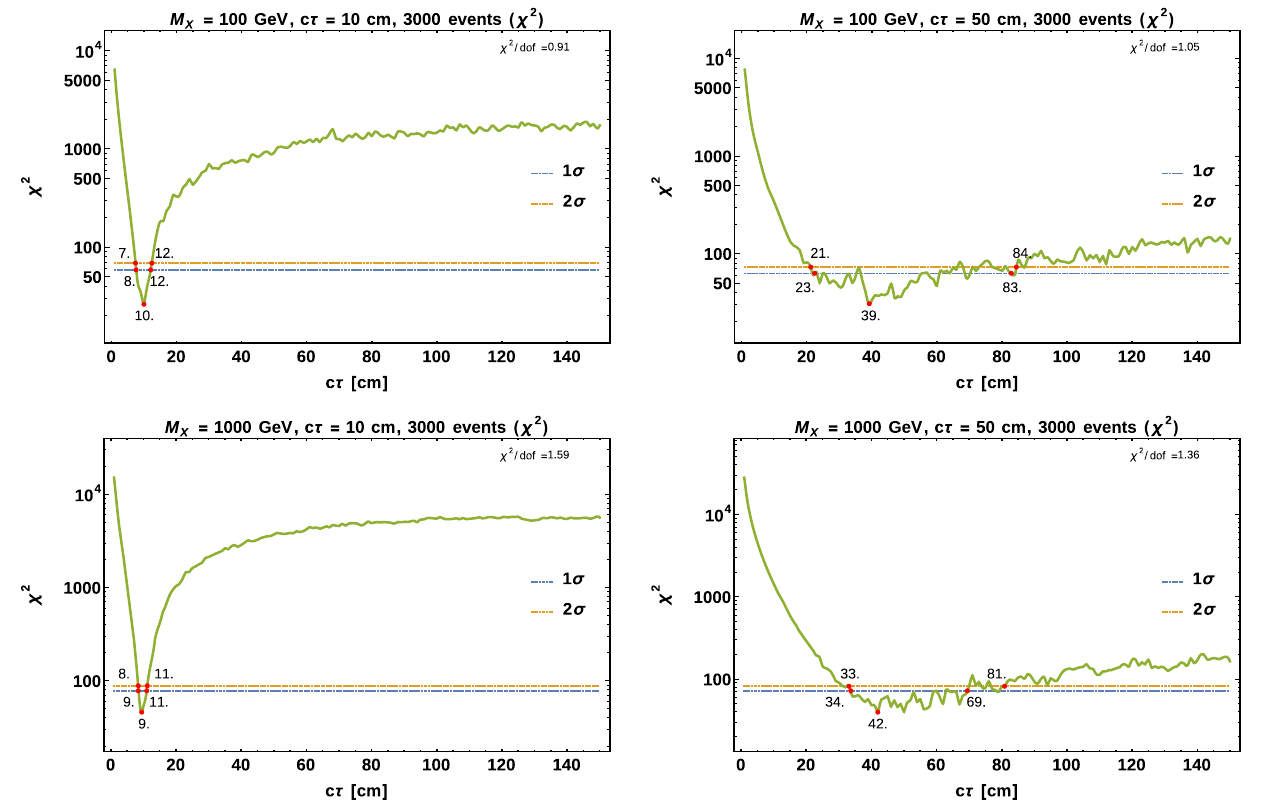
Fig. 16 Model-dependent χ 2 as a function of the reconstructed decay length c